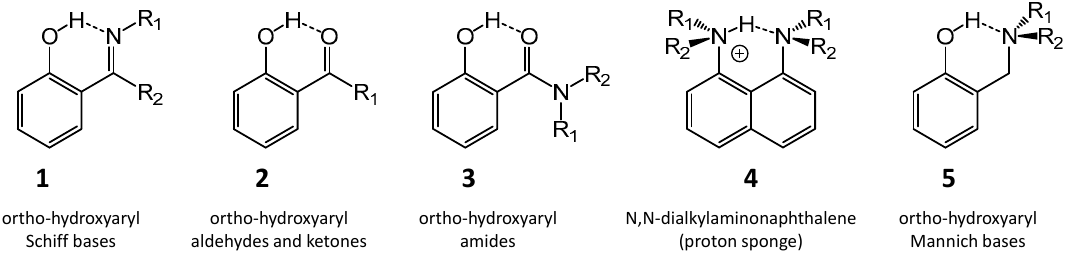
Figure 1. Schematic structures of compounds discussed in this work. R 1 and R 2 = hydrogen, aryl and alkyl substitutions.